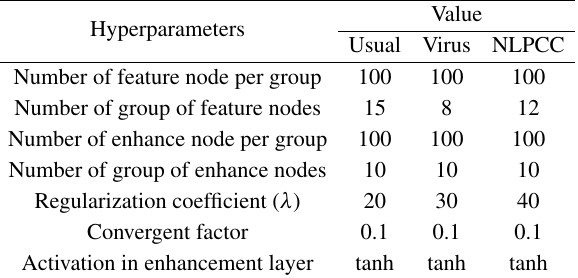
Table 4 The hyperparameters of p -BL.